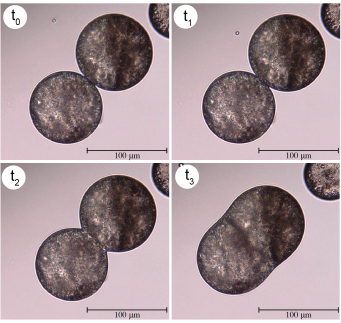
Figure 3. Snaphots from binary coalescence experiments with PA12 particles at di ff erent times, t 0 = 0 . 0 ( a / R ): contact point, t 1 : 0 . 1 ( a / R ), t 2 = 0 . 2 ( a / R ), t 3 = 0 . 8 ( a / R ) .